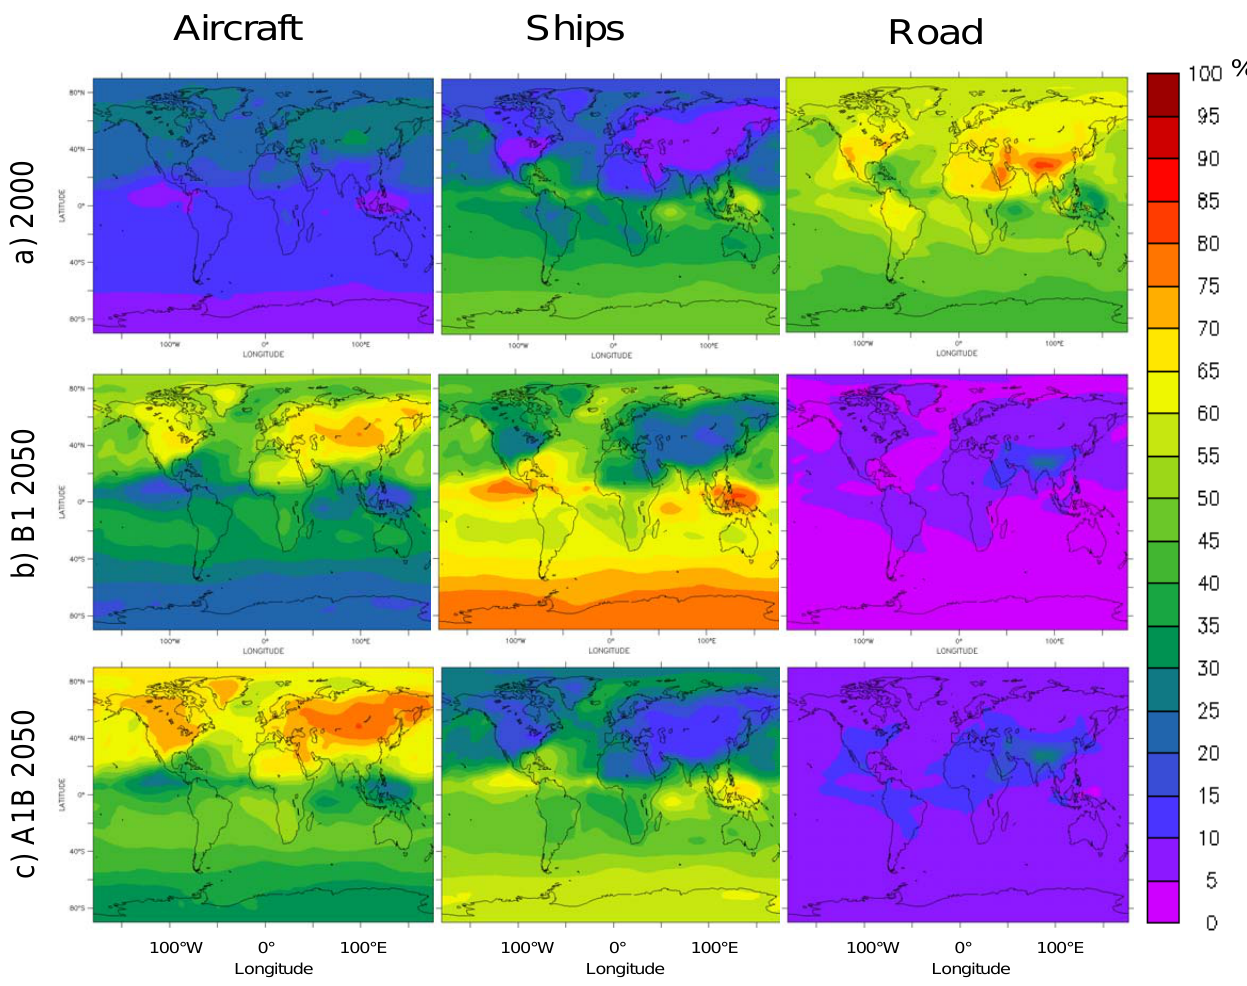
Fig. 2. Respective contribution (%) of each transport mode to the tropospheric ozone column change due to transport in July, for 2000 (A experiment) and 2050 (B1 and A1B scenarios; B and C experiments, respectively)